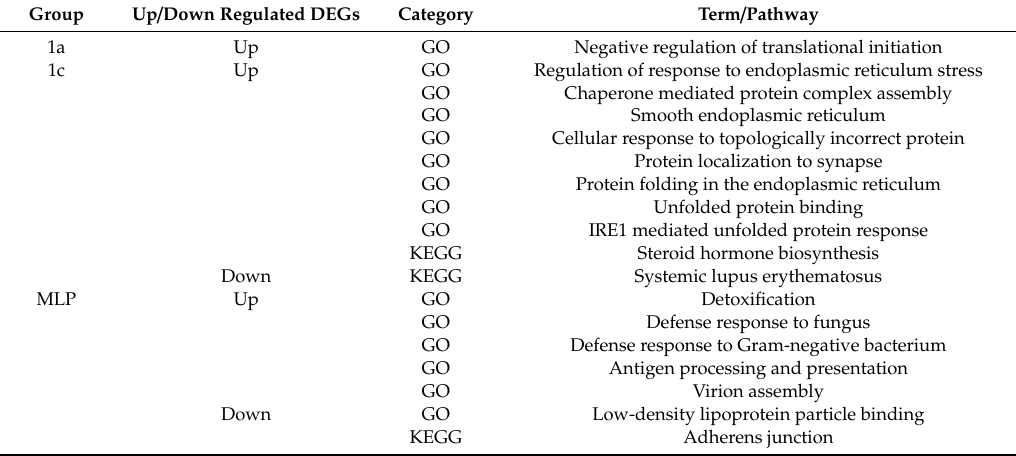
Table 2. Significantly enriched GO and KEGG terms / pathways identified by gene set enrichment analysis